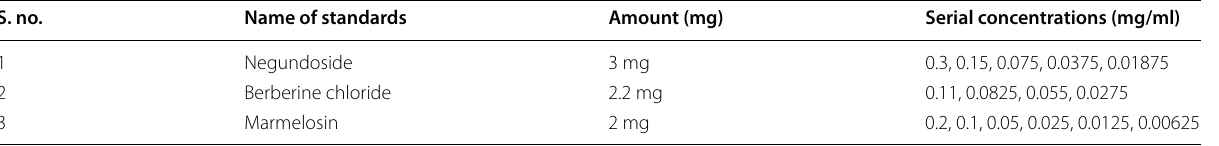
Table 3 Details of calibration concentration dilutions of different standards S.